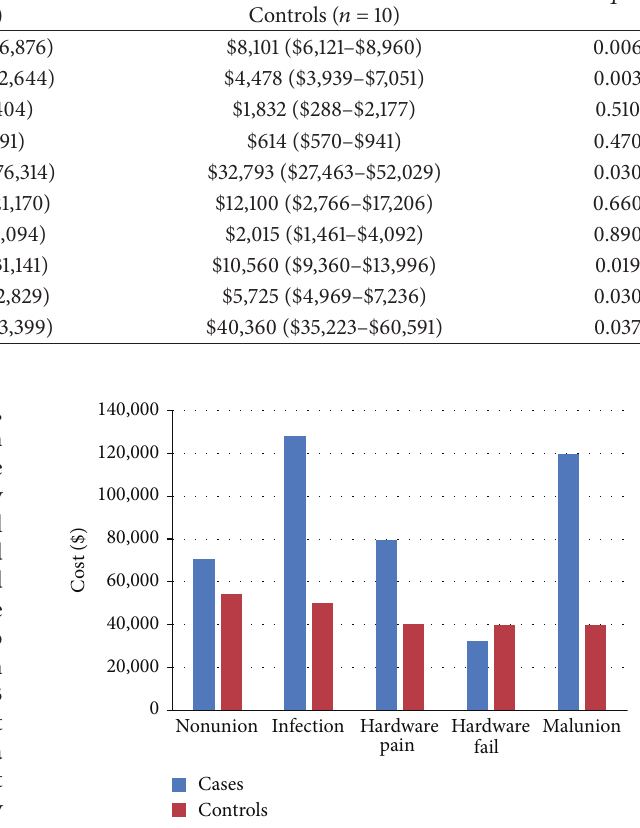
Figure 3: The total charges for each complication are compared to controls. ∗ Malunion: only one patient had a